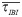
Statistical properties of SBs at different DIVs.Measured quantities of SBs as a function of DIV (N = 18): a) Mean firing rate (f) within 10 min. b) Mean inter-burst interval (τIBI¯). c) Average number of spikes within SBs (n). d) Mean burst duration τB¯. e) Mean number of spikes within a burst. The error bars are one standard deviation from 18 samples. The classification of three types of SBs are also shown as I, II and III. Note that for a), the firing rate is computed from all the detected spikes not just limited to those within a SB.